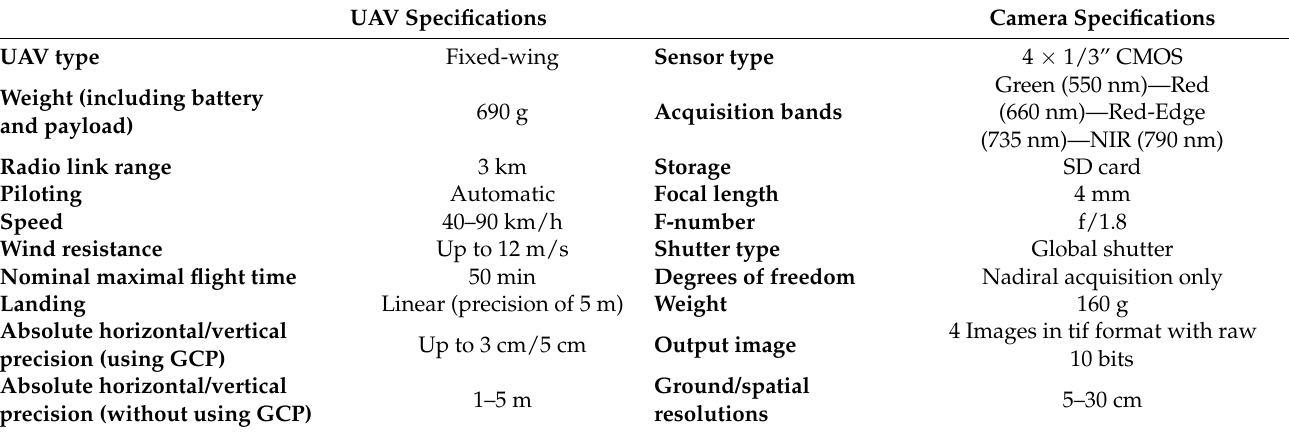
Figure 4. ( a ) eBee Classic; ( b ) Airinov MultiSPEC 4C camera (Sensefly; Airinov). Table 1. UAV and camera